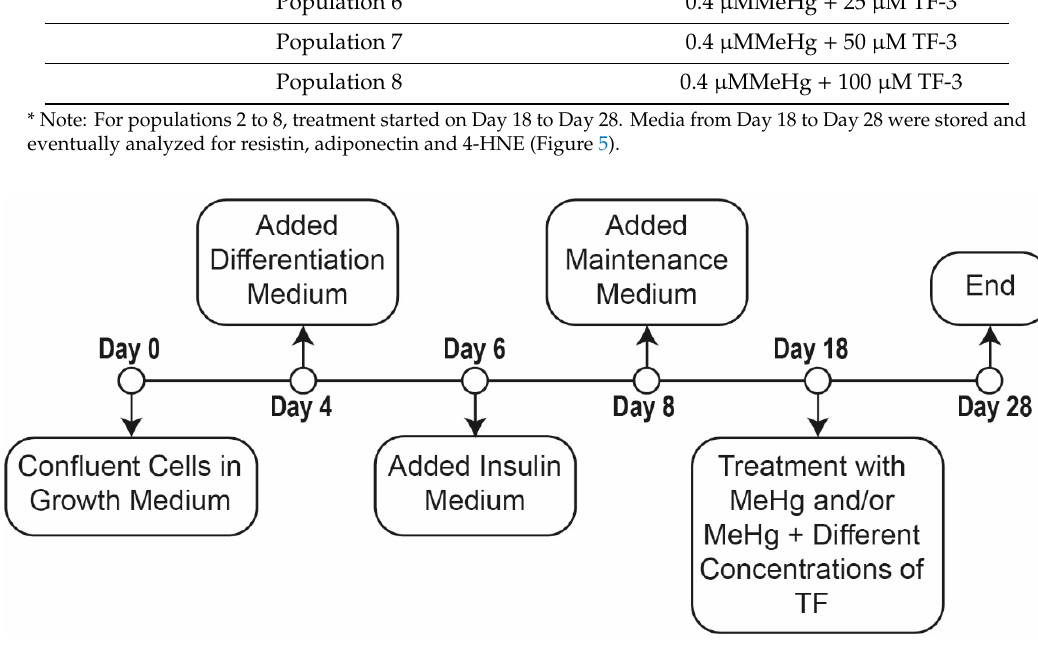
Table 1. List showing study groups of different populations.